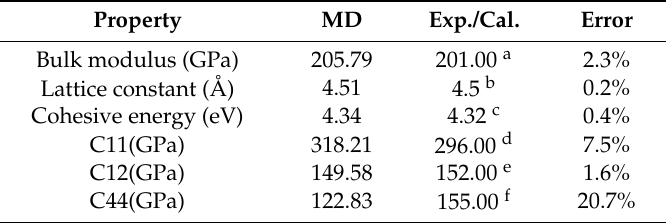
Table 1. Properties of B3-GaN obtained from molecular dynamics (MD) and Exp./Cal. (Exp. and Cal. represent the results from the experiments and density functional theory (DFT), respectively).